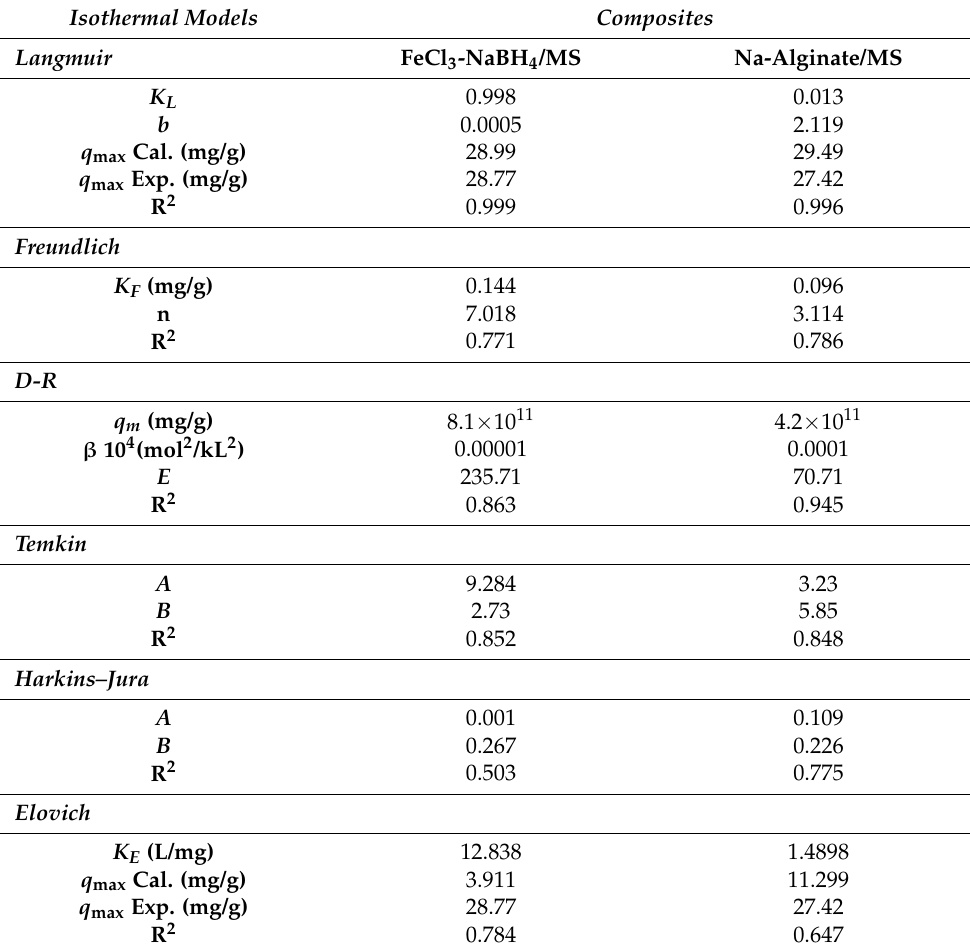
Table 2. Equilibrium isothermal constant parameters of 2,4,6-TCP onto FeCl 3 -NaBH 4 /MS and Na-Alginate/MS composites.